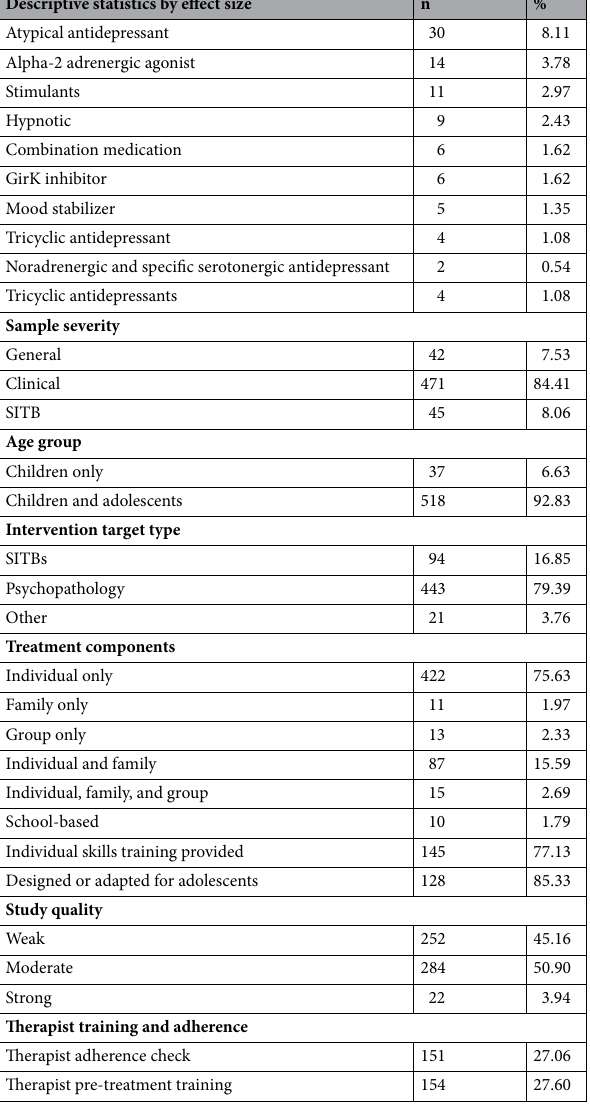
Table 1. Descriptive statistics for included